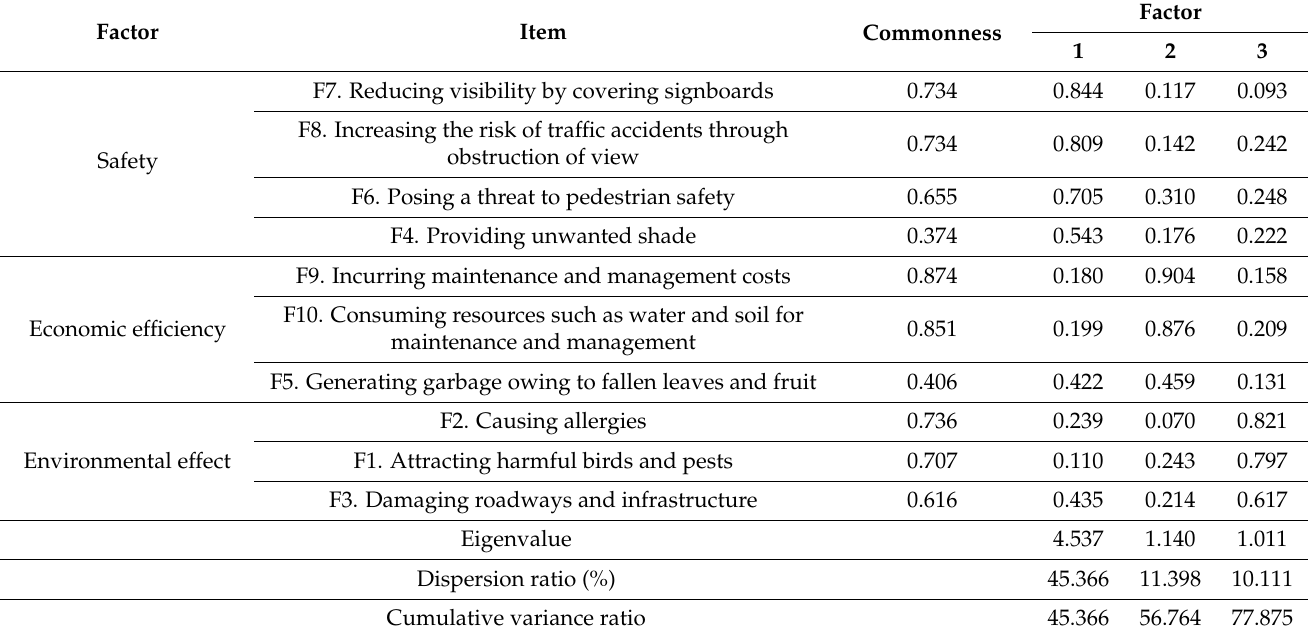
Table 9. Classification of problems caused by street trees into homogeneous